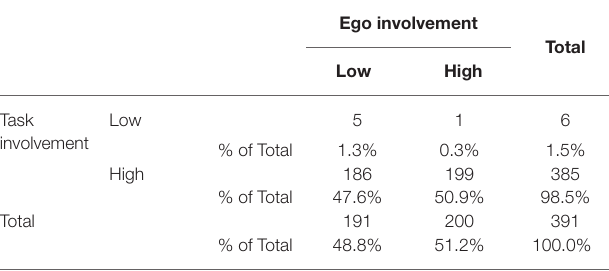
TABLE 2 | Cross tabulation of task and ego involvement with % of